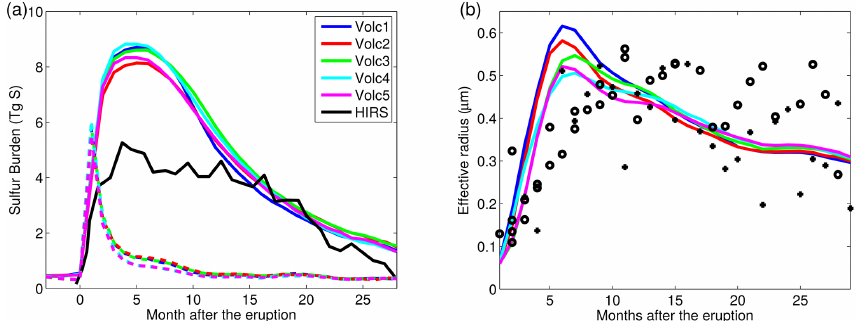
Figure A1. (a) Global SO 2 (dashed lines) and particulate sulfate (solid lines) burdens after a simulated volcanic eruption in July compared to sulfate observations from HIRS satellite after the 1991 Pinatubo eruption (black). (b) Zonal mean effective radius at 53 ◦ N latitude after the simulated July eruption compared to lidar measurements at Laramie 41 ◦ N (dots) and Geesthacht 53 ◦ N (crosses) after the Pinatubo eruption (Ansmann et al., 1997). In both panels the results are shown for altitude range 16–20km. The different coloured lines show results from the five members of the simulated ensemble (simulations Volc1, ..., Volc5).